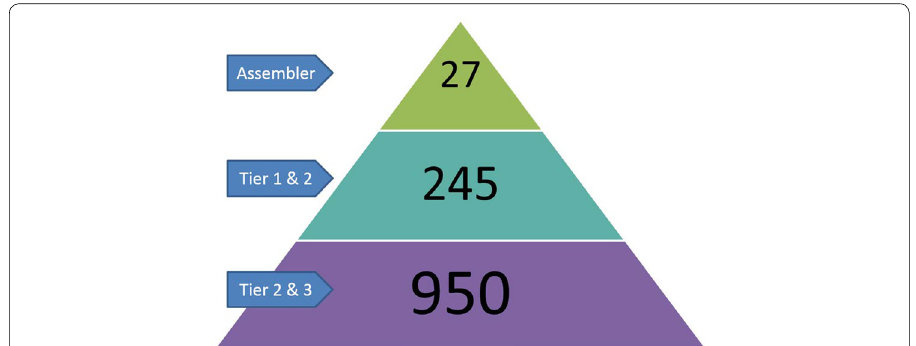
Fig. 3 Pyramid structure of automotive industry in Indonesia. Source : Based on interview of Indonesian Automotive Component Industry Cooperative (KIKO) of Indonesia and Japan Economic Research Institute Inc (JETRO). Asian Industrial Foundation Development Research in FY 2014: Fact Finding Survey on Local SMEs in Indonesia Japan Economic Research Institute Inc.